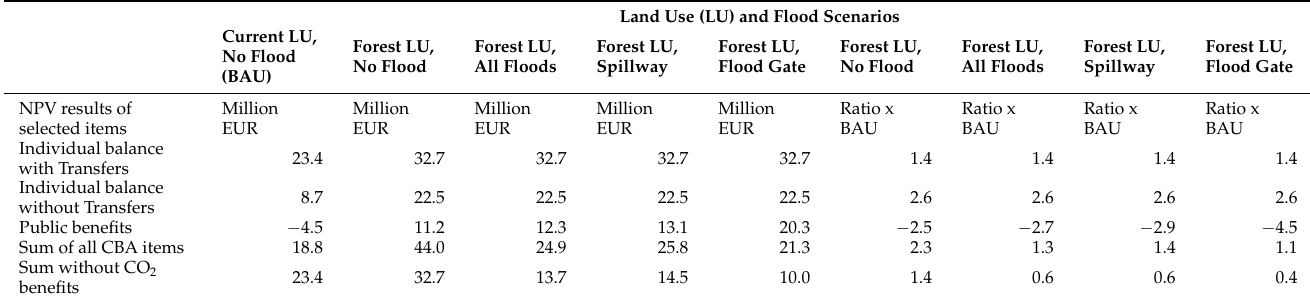
Table 6. Forest land use scenarios compared to business-as-usual (BAU) (Monetary values are net present values in million EUR. “Ratio x BAU” columns compare scenario results to the “Current LU, no flood” scenario. “Individual balance” refers to the land users’ financial position with and without EU CAP payments. “Public benefits” are the sum of the flood risk reduction benefits and the shadow price of CO 2 sink. “Sum of all CBA items” includes all individual and public cost and benefits items together with the investment costs.) Source: Own